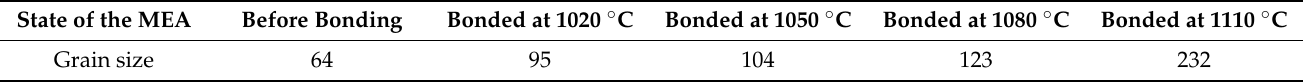
Figure 5. Microstructure of the (CoCrNi) 94 Al 3 Ti 3 MEA/DD5 single-crystal superalloy joints diffusion-bonded at different temperatures: ( a , b ) 1020 °C, ( c , d ) 1050 °C, and ( e , f ) 1080 °C. Table 2. Grain size of the (CoCrNi) 94 Al 3 Ti 3 MEA in different states ( µ